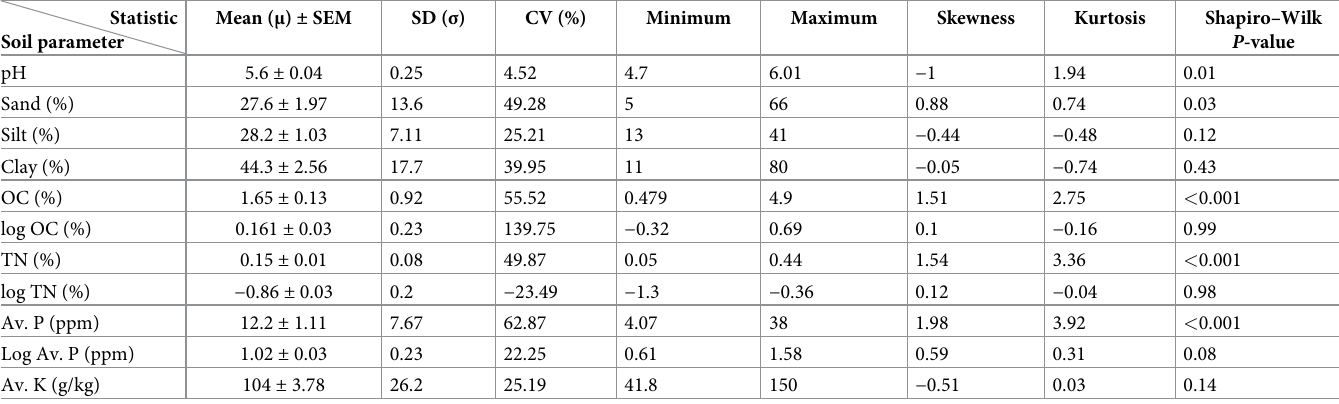
Table 1. Descriptive statistics and Shapiro–Wilk probability test of soil parameters in Aba Gerima catchment, Blue Nile basin. Statistic Soil